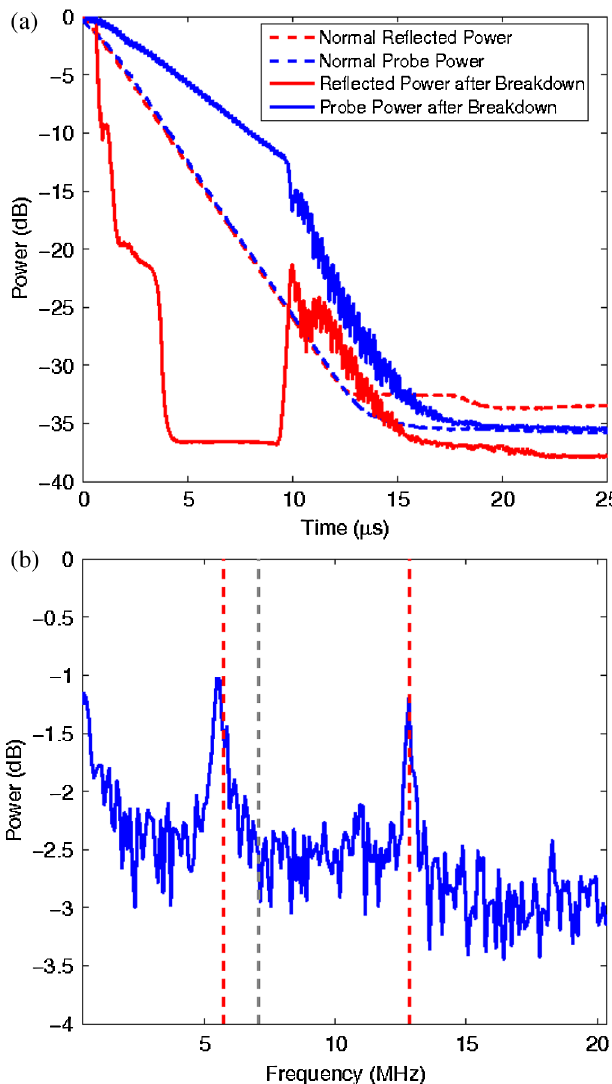
FIG. 7. (Color) (a) Same description as Fig. 6(a). (b) Same description as 6(b) but for the 0 – 9 (cid:1) s data, and the case where the second iris is blocked in the